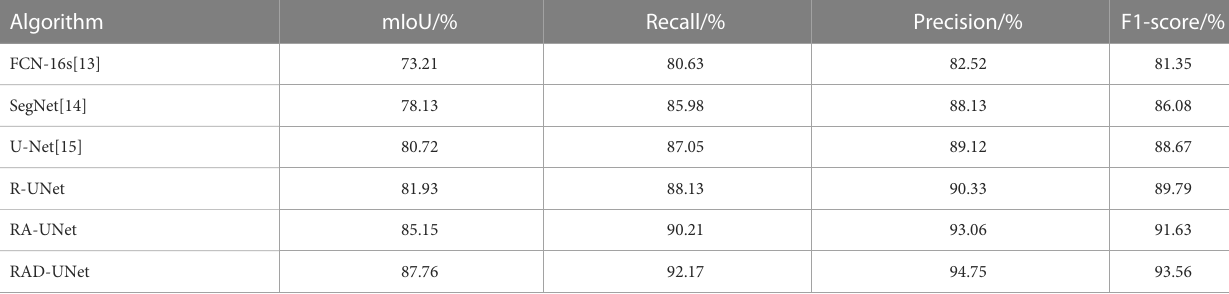
TABLE 1 Segmentation results of different algorithms in terms of multiple metrics on the LIDC test set.